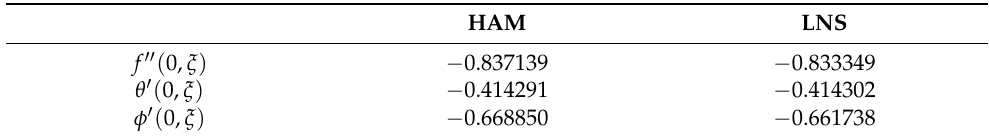
Table 1. Comparison of numerical solutions with β = 0.1, λ 2 = 0.2, Pr ef f = 1.0, D f = 0.5, Sc = 1.0, and Sr = 0.5 for τ = 0.75 and η ∈ [ 0,10 ]